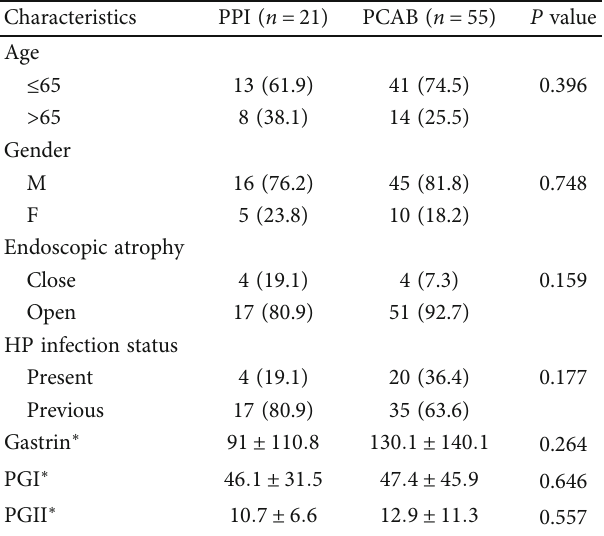
Figure 1: Flowchart showing data of patients enrolled in this study. Table 1: Clinical characteristics of patients in each